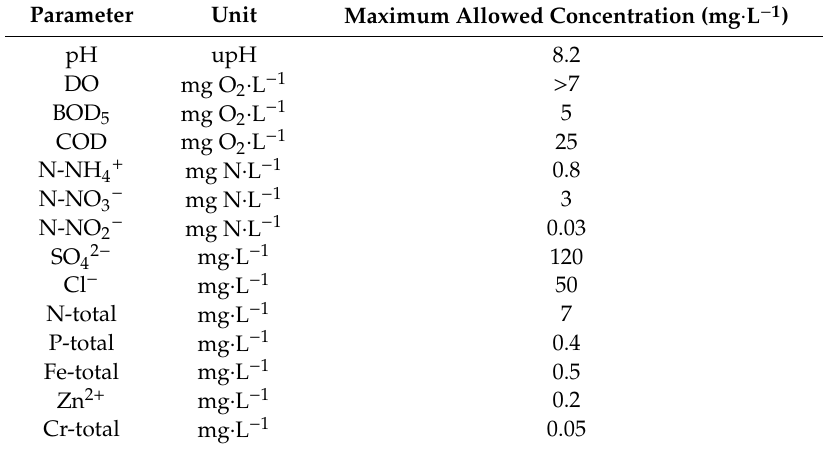
Table 2. Maximum allowed concentration of each parameter regulated by Order 161 / 2006 [38].